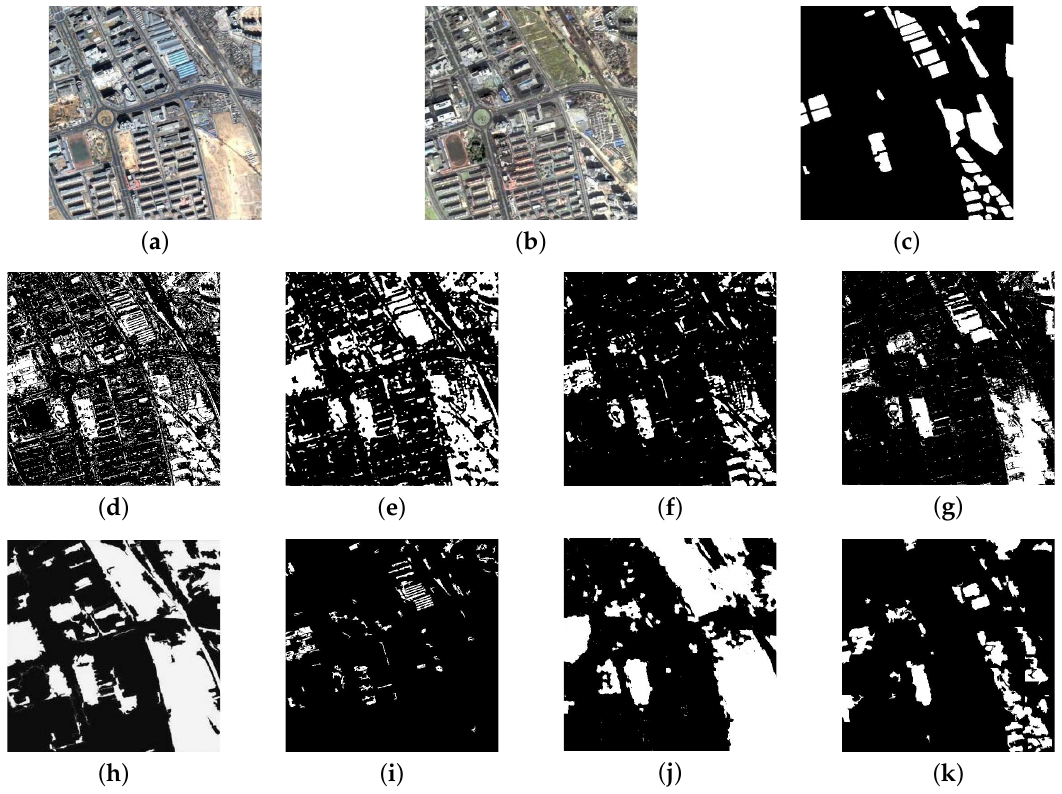
Figure 7. The first image pairs and the results of different methods. ( a ) Image in 2002; ( b ) image in 2003; ( c ) ground truth; ( d ) EM-based; ( e ) Markov random field (MRF)-based; ( f ) PCA-based; ( g ) parcel-based; ( h ) fast object-level; ( i ) MBI-based; ( j ) sparse hierarchical clustering (SHC)-based; ( k )